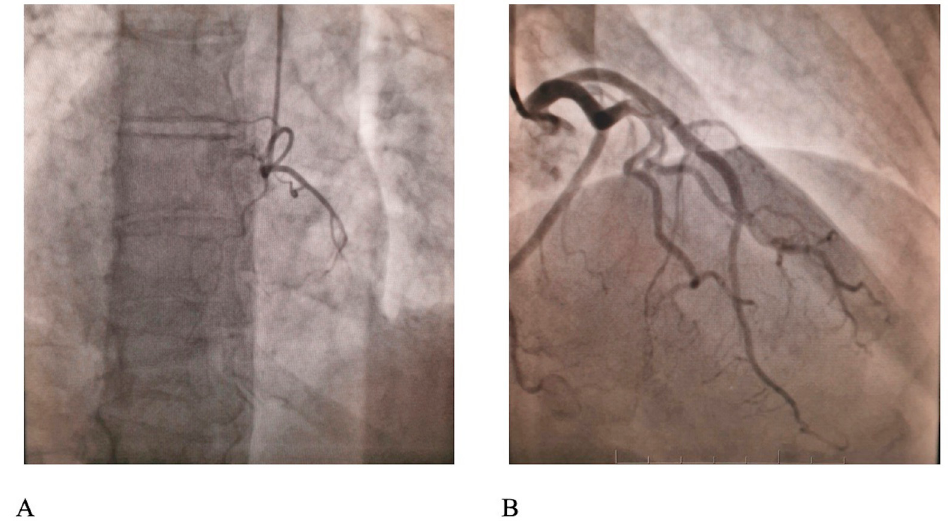
Figure 2. Coronary angiogram displaying normal ( A ) right and ( B ) left coronary arteries.